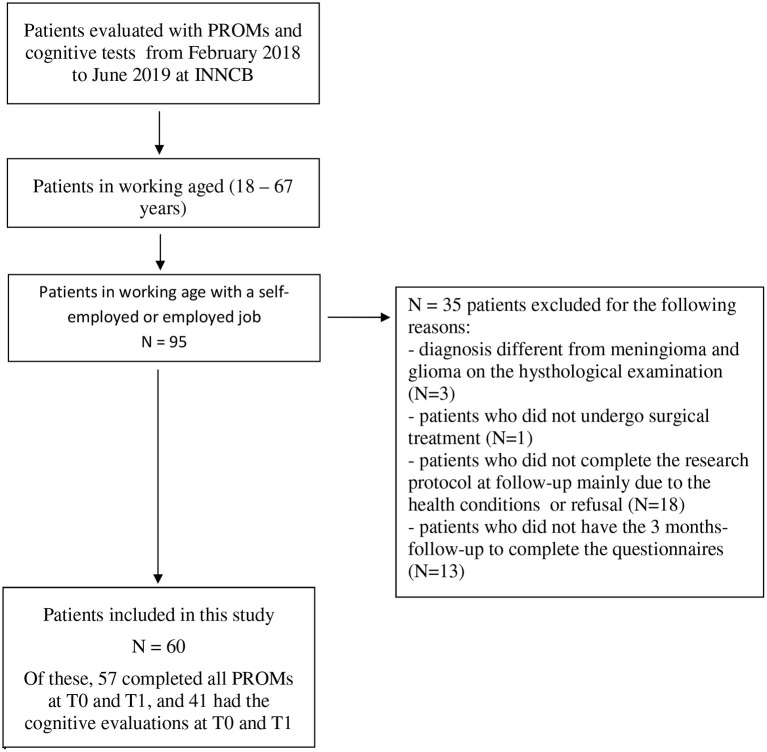
Patient selection.